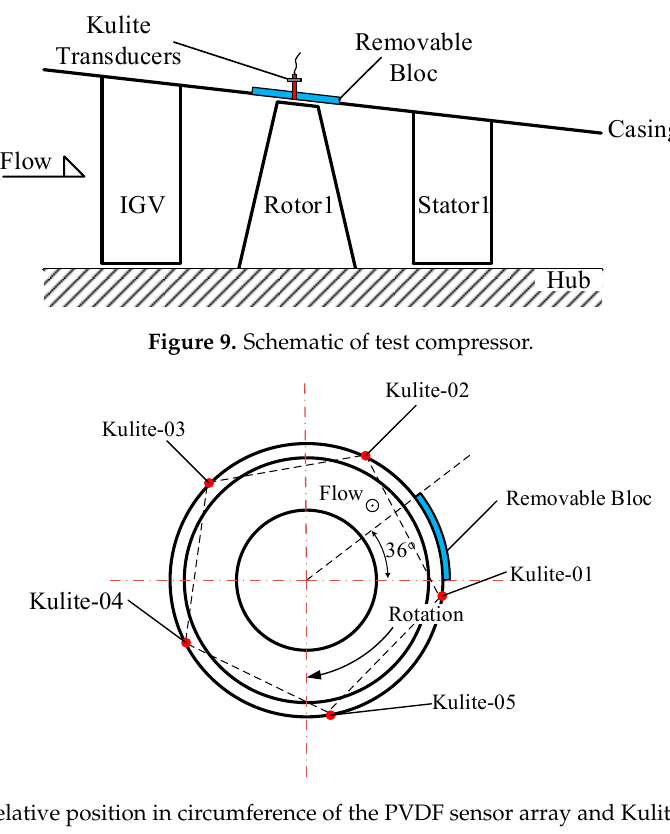
Figure 8. The relation between sensitivity and temperature.